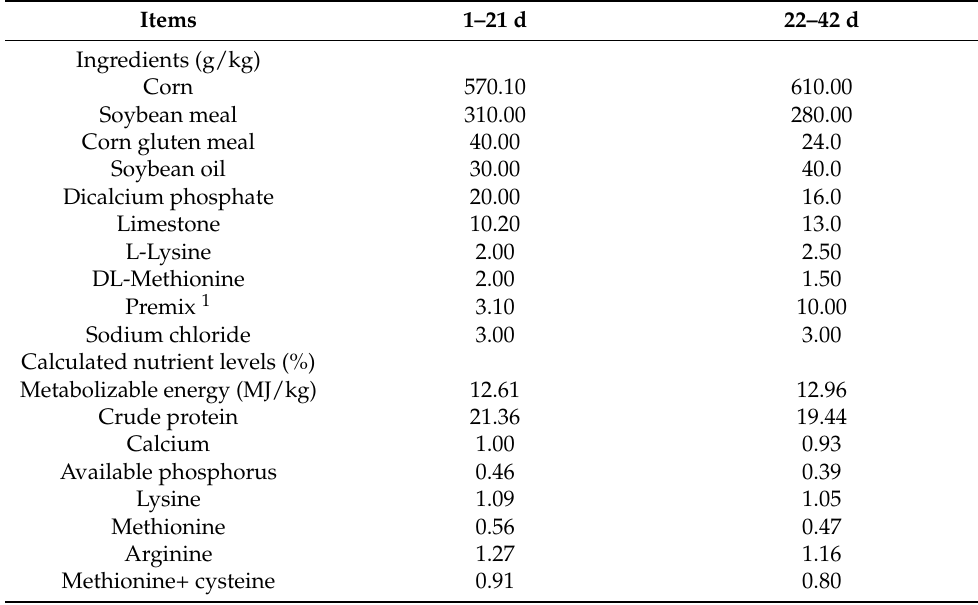
Table 1. Composition of feed ingredients (g/kg) and nutrient level (%) as-fed